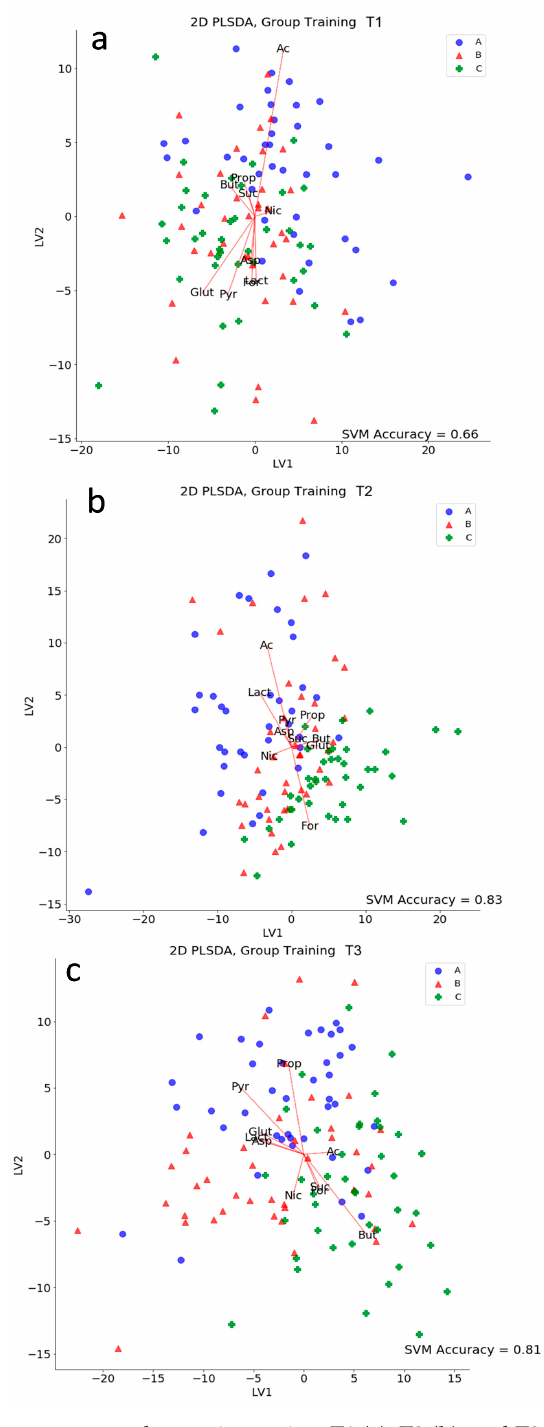
Figure 6. Partial least square score plots at time points T1 ( a ), T2 ( b ), and T3 ( c ). The support vector machine classifier accuracy score is reported at each time point in order to highlight at which time the e ff ects of the treatment are more detectable in the metabolic space (T2). Red arrows mark the directions of maximum expression in the metabolic space for each metabolite of interest. Points scattered along a particular direction are expected to be characterized by an abundance of the related